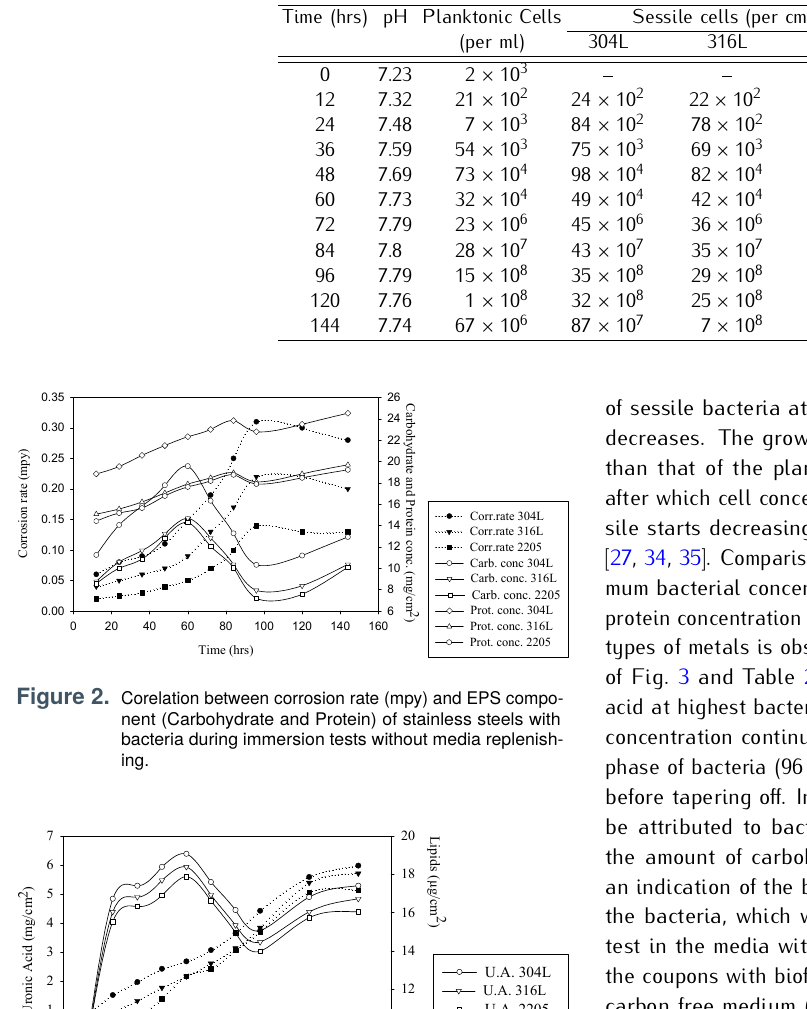
Table 2. Bacterial counting of Desulfotomaculum nigrificans ( DN ) by MPN Method.